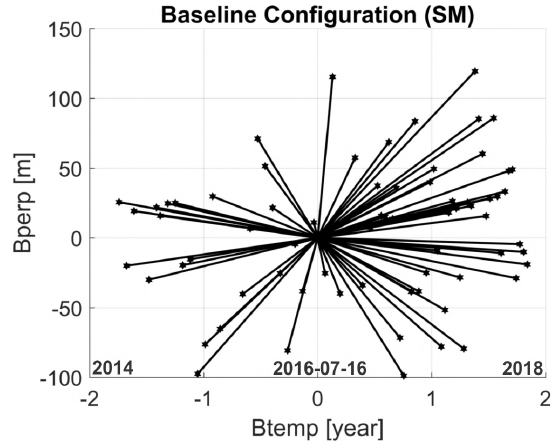
Figure 3. The baseline plot of SM interferograms Results from the Conventional SM method